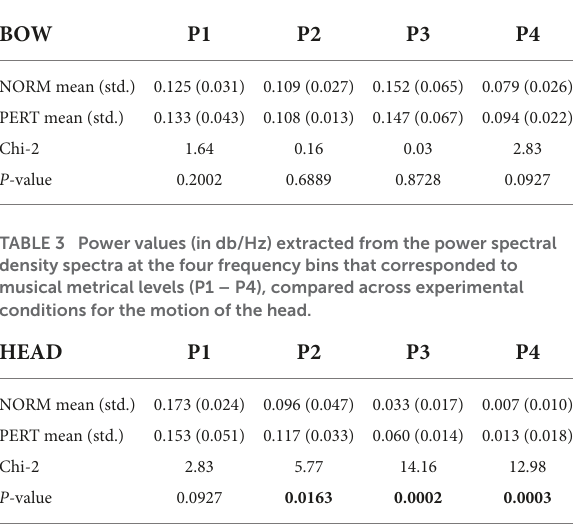
TABLE 4 Correlation coefficients representing the co-evolution of V1’s head and bow power spectral density at the four frequency bins that corresponded to the piece metrical levels (P1 – P4), compared across experimental